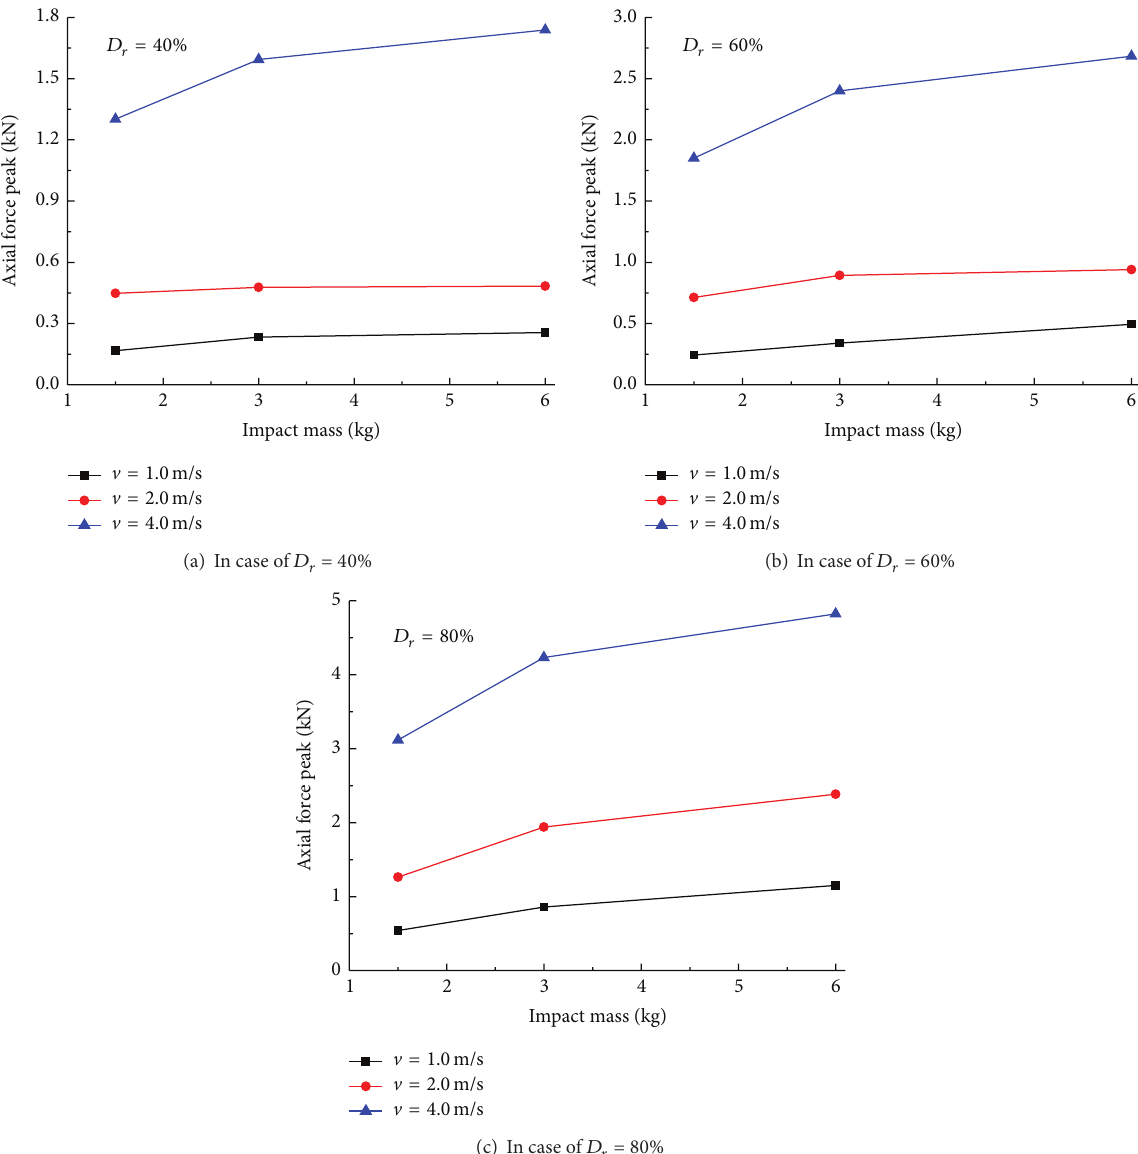
Figure 18: Effect of impact mass on peak axial